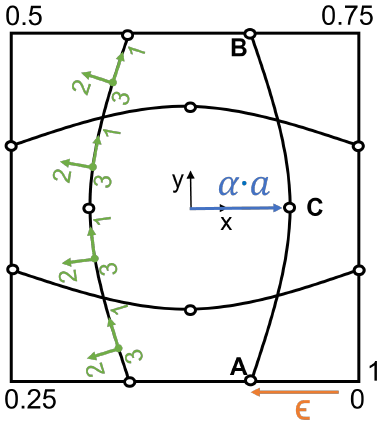
Figure 6. Stiffener layout.